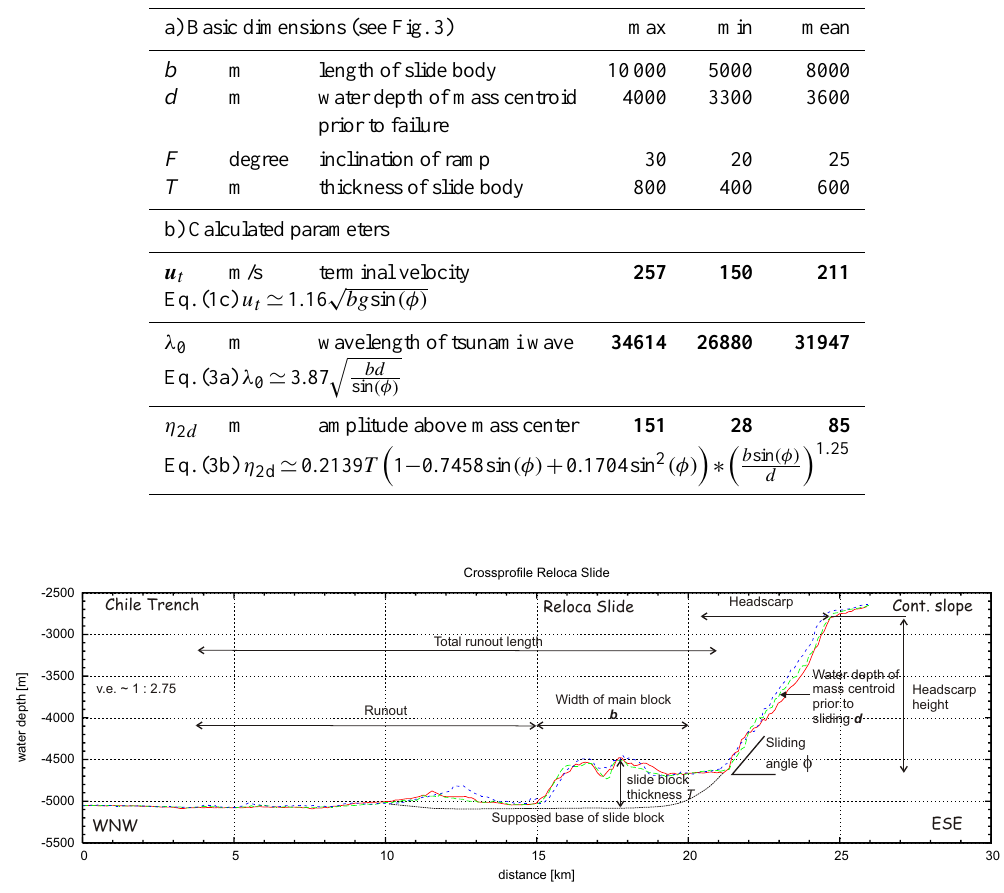
Fig. 3. Depth profile across Reloca Slide, showing major morphological elements and properties. The position of profiles is indicated in Fig. 1 as thin, dotted lines.